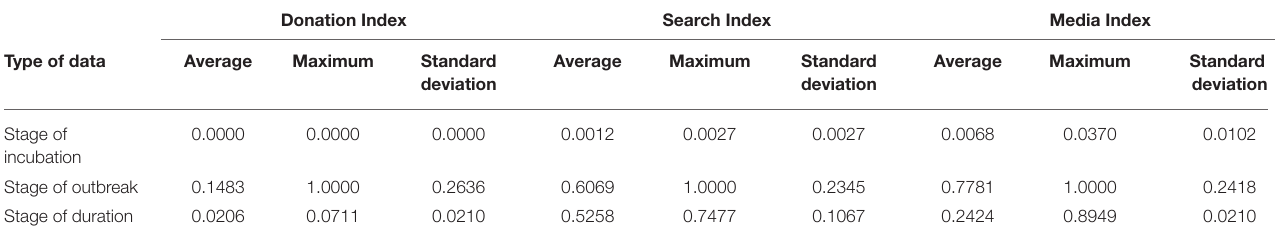
TABLE 3 | Donation index, search index, and media index in three